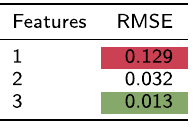
Table 6 Bitcoin prediction errors. Root Mean Square Error (RMSE) of predictions considering (1) only Bitcoin returns and then sequentially adding sentiment (2) and sadness (3) time series as features